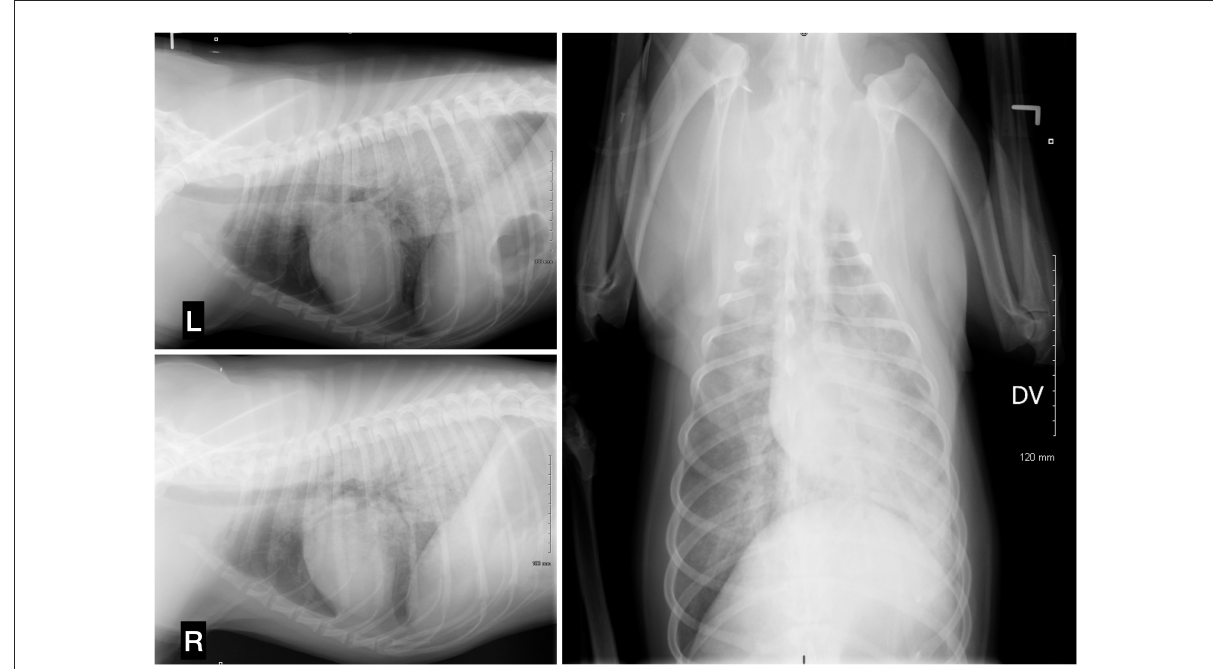
FIGURE1 Thoracic radiographs, 3 projections (left lateral, right lateral, and dorsoventral). A severe alveolar lung pattern is present in the perihilar region and caudodorsal lungs, mainly distributed on the right side. There is a moderate diffusely distributed broncho-interstitial lung pattern in the left cranial and right cranial and right middle lung lobes. The cranial pulmonary vessels are very small and there is a narrowing of the caudal vena cava. The aorta cannot be identified due to superimposition. Trachea, cardiac silhouette, and diaphragm appear within normal